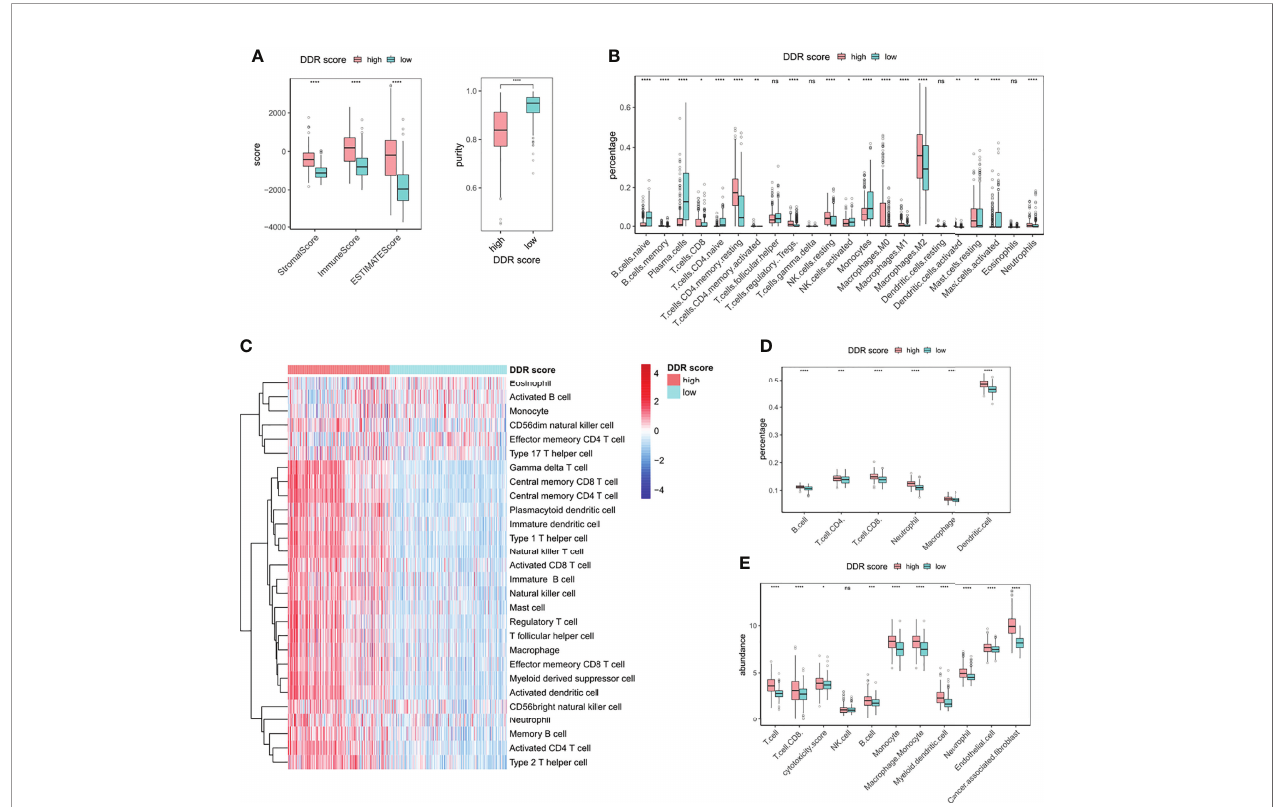
FIGURE 5 | Immune in fi ltrating patterns of DDR score phenotypes. (A) Levels of stromal score, immune score, estimate score, and tumor purity in high and low DDR score groups. (B) The fractions of 22 types of immune cells in high and low DDR score groups based on CIBERSORT. (C) The in fi ltrating levels of 28 subpopulations of immune cells in high and low DDR score groups based on ssGSEA. (D) The percentages of six immune cell types in high and low DDR score groups based on TIMER. (E) The abundances of eight immune and two stromal cell populations in high and low DDR score groups based on MCP-counter. *p < 0.05; **p < 0.01; ***p < 0.001; ****p < 0.0001; ns, no signi fi